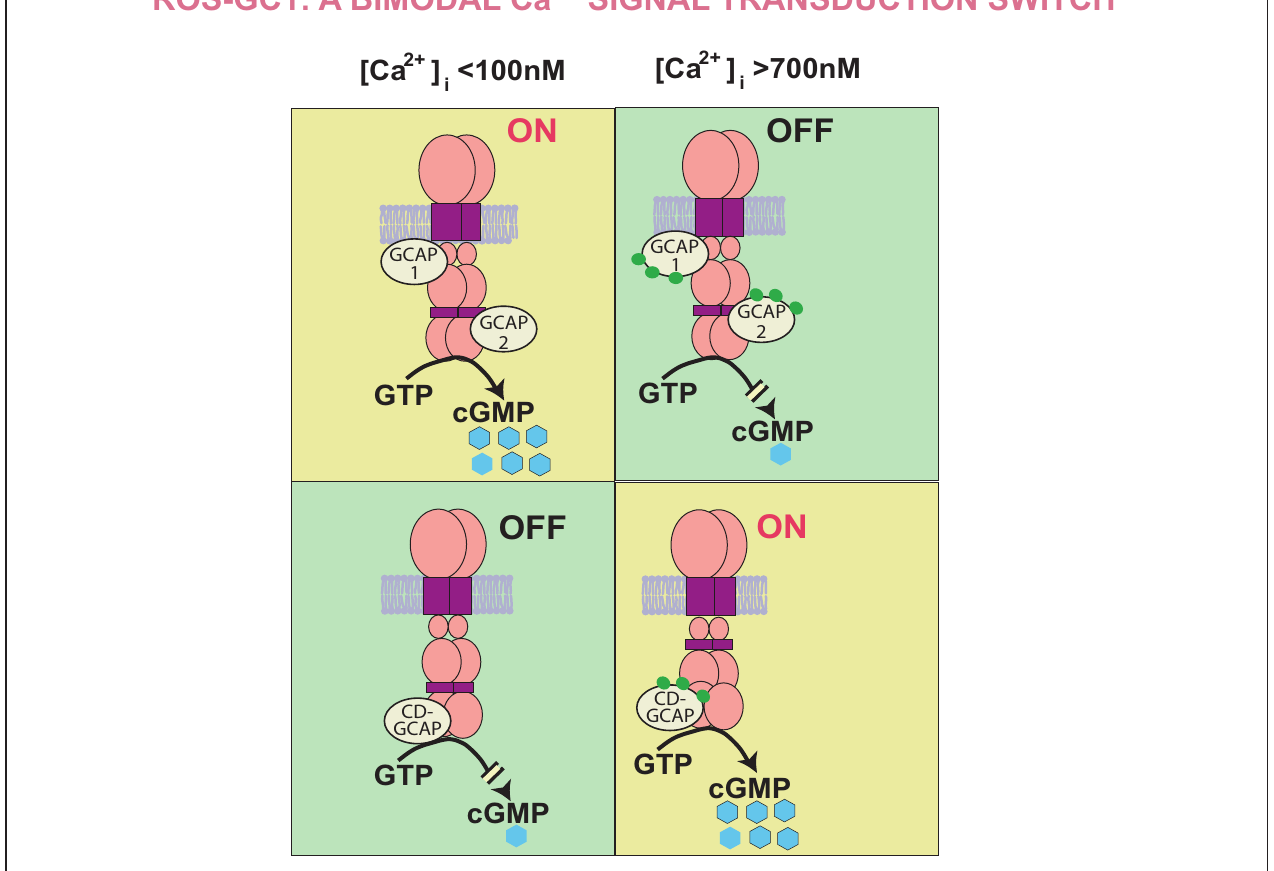
CD-GCAPs is about 700nM. Thus, in the GCAPs operational mode CD-GCAP switch is “OFF” and in the CD-GCAPs operational mode GCAP switch is “OFF” [reformatted and upgraded from Figure 3 with permission from Sharma et al. (2004) and Figure 4: Sharma